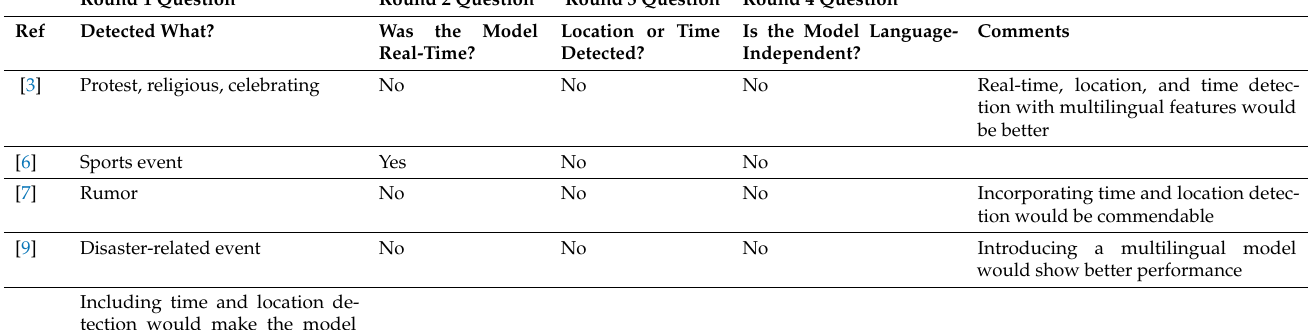
Table 7. Qualitative performance evaluation of our studied articles using Delphi